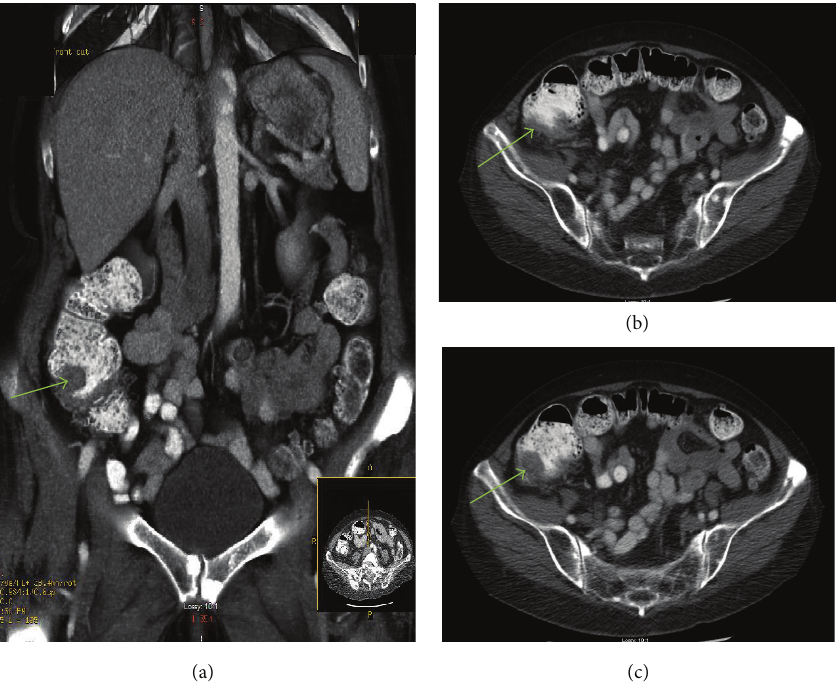
Figure 1: CT abdomen and pelvis. (a) (coronal view) and (b) and (c) (axial views) show an area of irregular wall thickening in the cecum (green